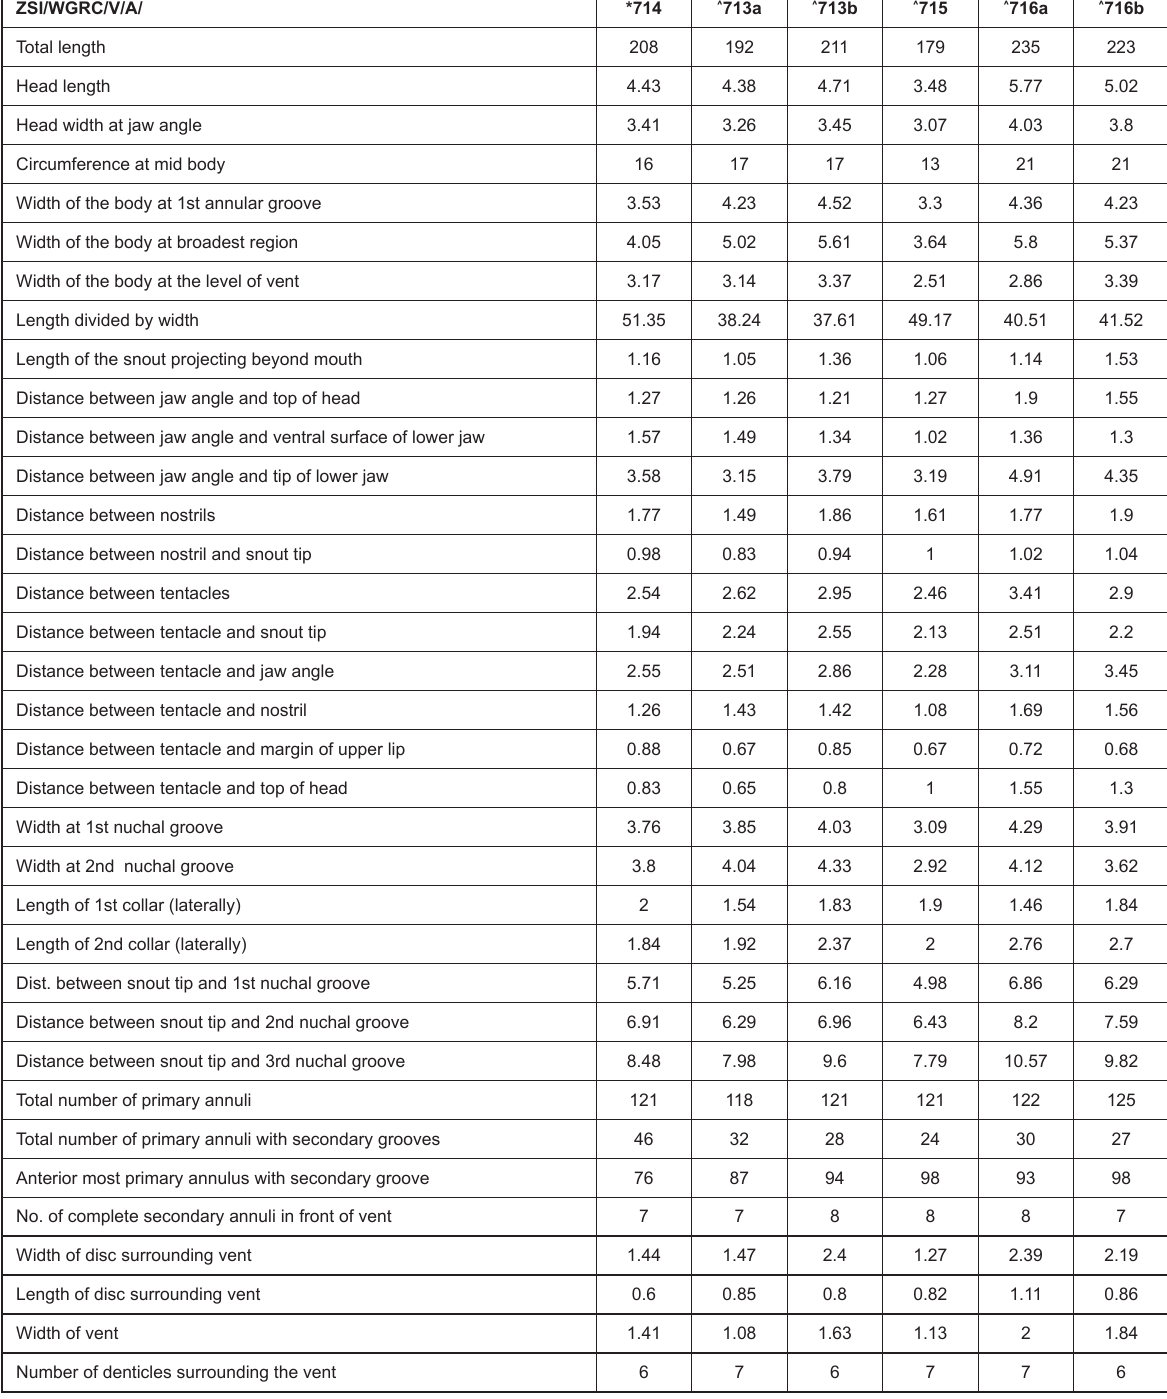
Table 3. Some morphometric (in mm) and meristic data for G. goaensis and G. mhadeiensis . Measurements were made to the nearest 0.1mm with dial calipers, except for length and circumference, which were measured with a ruler and a piece of